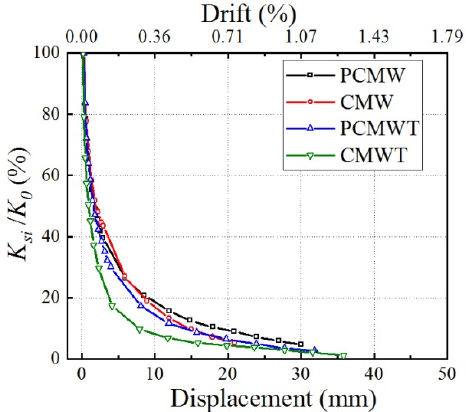
Figure 10. Normalized stiffness degradation of